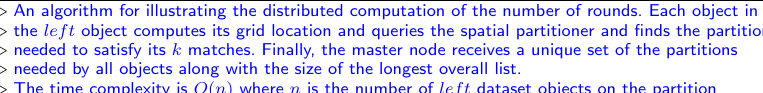
Algorithm 2 Computing the Number of Processing